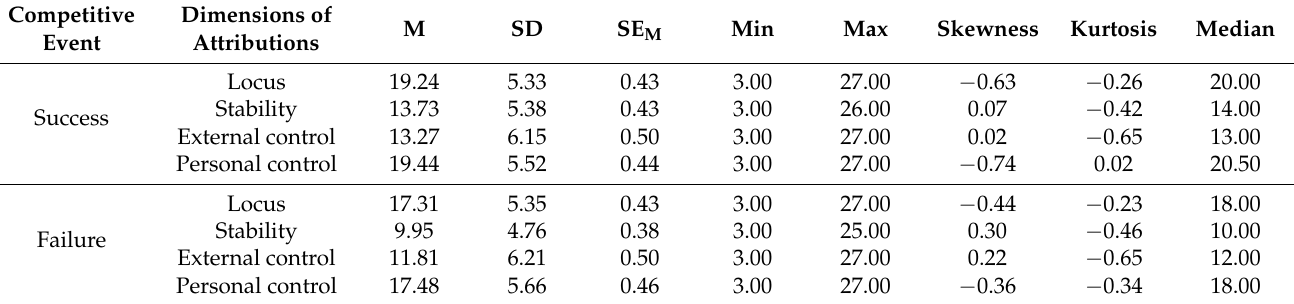
Table 1. Summary statistics table for interval and ratio variables for all participants ( N = 154).